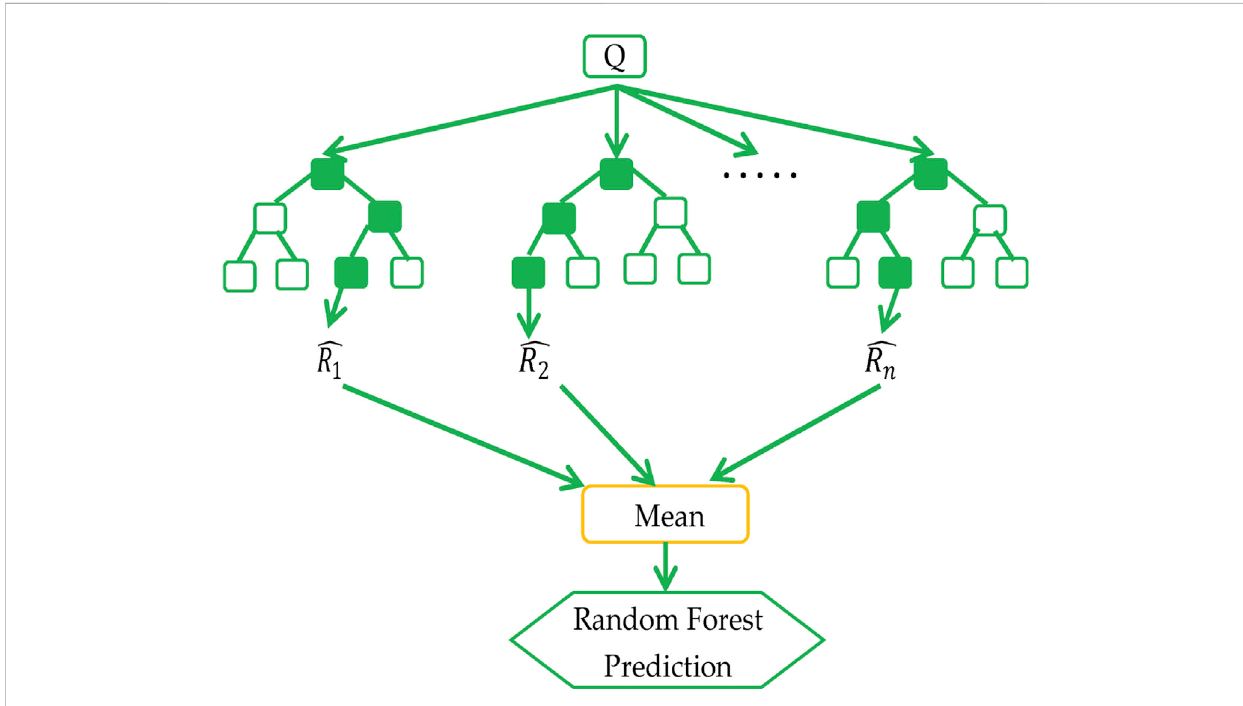
FIGURE 4 Structure of the Random Forest algorithm (Amjad et al.,